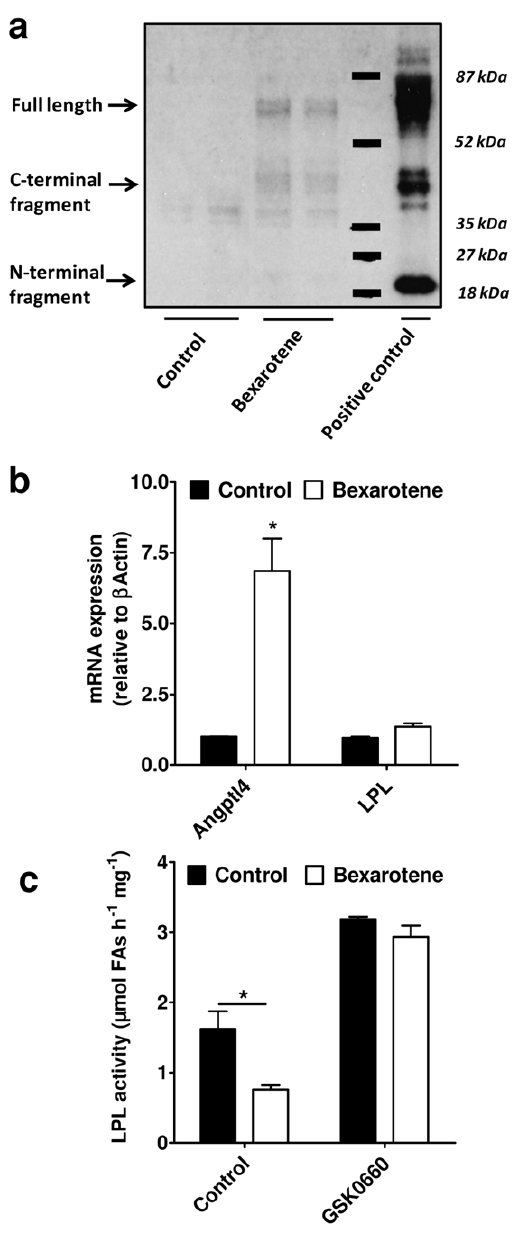
Figure 5. Regulation of Angptl4 expression and LPL activity by bexarotene in C2/LPL myotubes. ( a ) Secretion of Angptl4 from C2/ LPL myotubes was analyzed by Western blot 48 hours after incubation with DMSO (Control) or 0.2 m M bexarotene. Samples from two experiments were loaded on the gel. ( b ) Angptl4 and LPL mRNA levels were measured by real time PCR in C2/LPL myotubes incubated with DMSO (Control) or 0.2 m M bexarotene for 24 hours. Values are expressed relative to mouse 36B4 mRNA levels. ( c ) C2/LPL myotubes untreated or pre-treated overnight with 1 m M GSK0660, a PPAR d antagonist, were incubated with DMSO (Control) or 0.2 m M bexarotene for 4 hours. Heparin releasable LPL activity was measured and normalized to the protein content. * p , 0.05, Two-way ANOVA with Bonferroni post-tests.